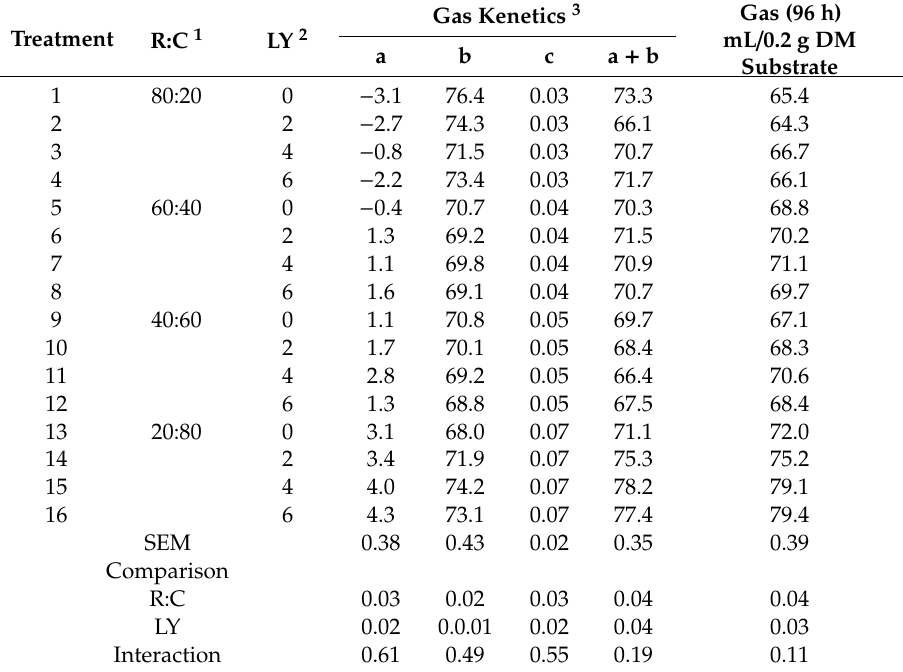
Table 2. The e ff ect of roughage-to-concentrate (R:C) ratio with live yeast (LY) supplementation on gas kinetics and cumulative gas